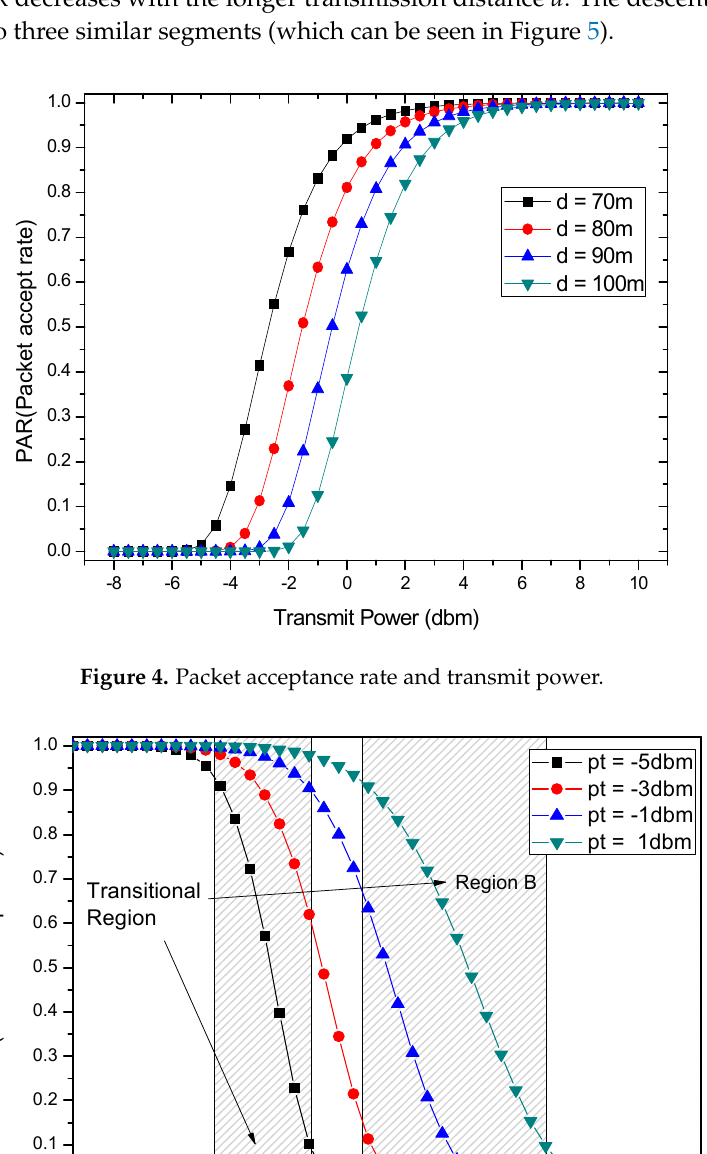
Figure 5. Packet acceptance rate and transmission distance.